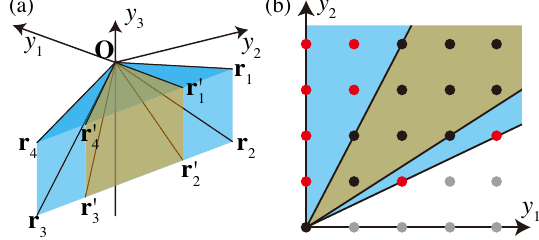
FIG. 4. (a) The cones Y and X for SG 70 ( Fddd ). The blue and yellow regions represent Y and X , respectively. The ray vectors = r 0 1 for Y=X are r 1 , respectively, given in the main text. ; 2 ; 3 ; 4 ; 2 ; 3 ; 4 (b) The projections of Y and X in the y 1 y 2 plane. The black points correspond to trivial symmetry data vectors B , the red points correspond to EFPs, and the grey points are